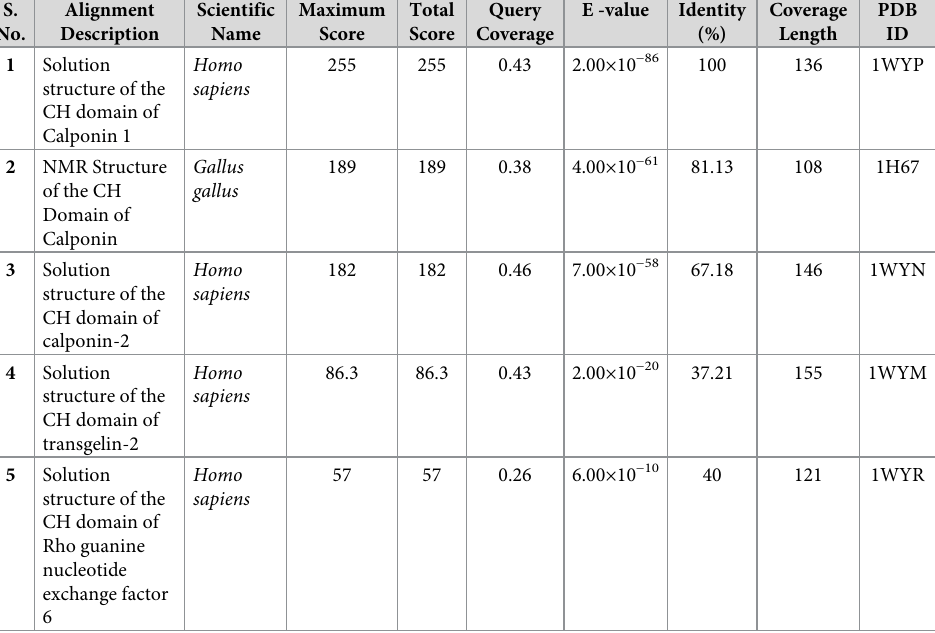
Table 7. Protein-BLAST alignment of CNN1 isoform 2